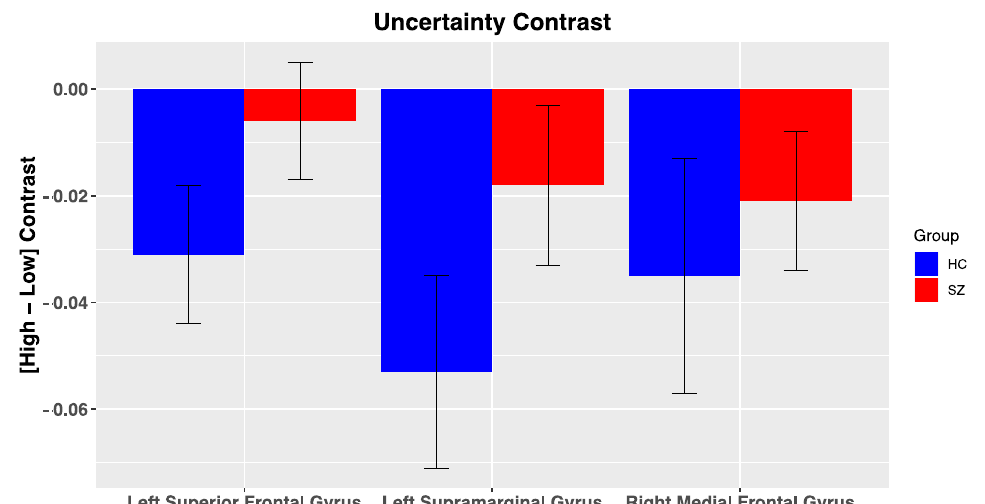
Figure 5. BOLD activation of Default Mode Nodes to fMRI contrasts : Error bars represent standard error of the mean; HC, healthy control; SZ, schizophrenia.